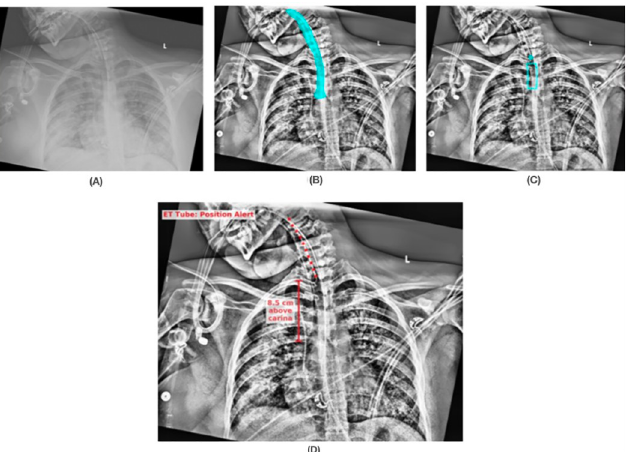
Fig 10. Visual example of nodes leading to determining incorrect ETT placement, determined by knowledge- supported machine reasoning. (A) Original chest x-ray image; (B) trachea region overlayed on an enhanced image; (C) ETT safe zone ( et_zone ) and tube tip location ( et_tip ) showing the tip outside the safe zone; (D) the final output of the system as presented to the physician with the red overlay indicating the system determination of incorrect tube placement (tip too high relative to the